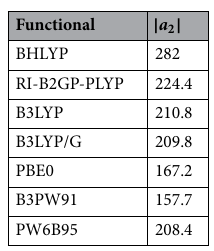
Table 3. HFCC | a 2 | ( µ T) using different DFT fuctionals.